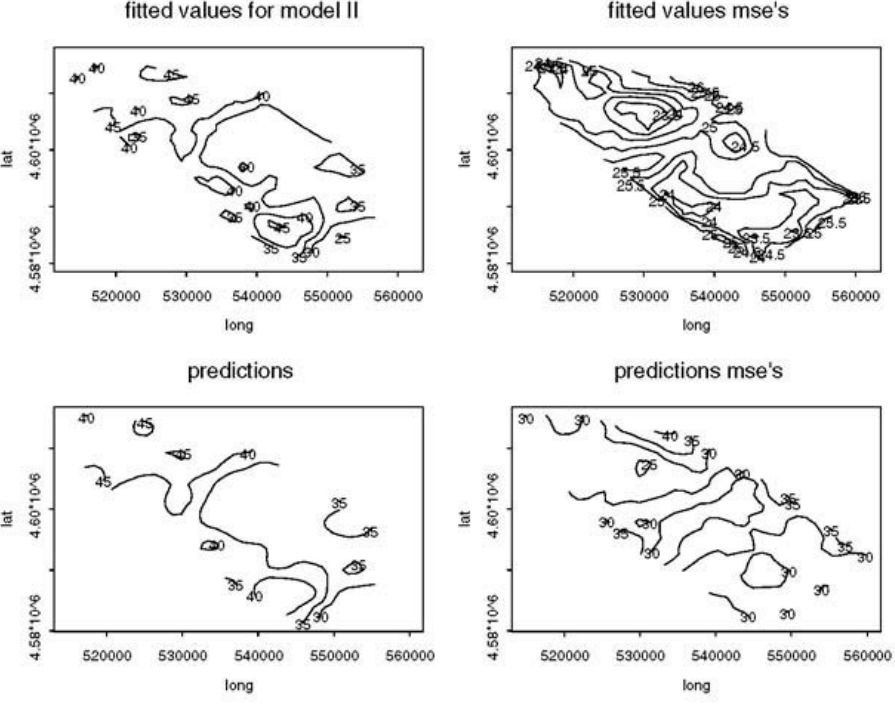
Figure 5 – Contourplots (based on a linear interpolation) of fitted values and predictions on a square grid for model II and their